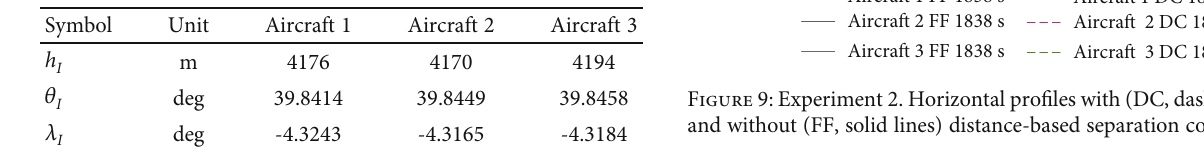
Table 4: Positions of the aircraft at con fl ict region (at time 980 s) without distance constraint for Experiment 2.